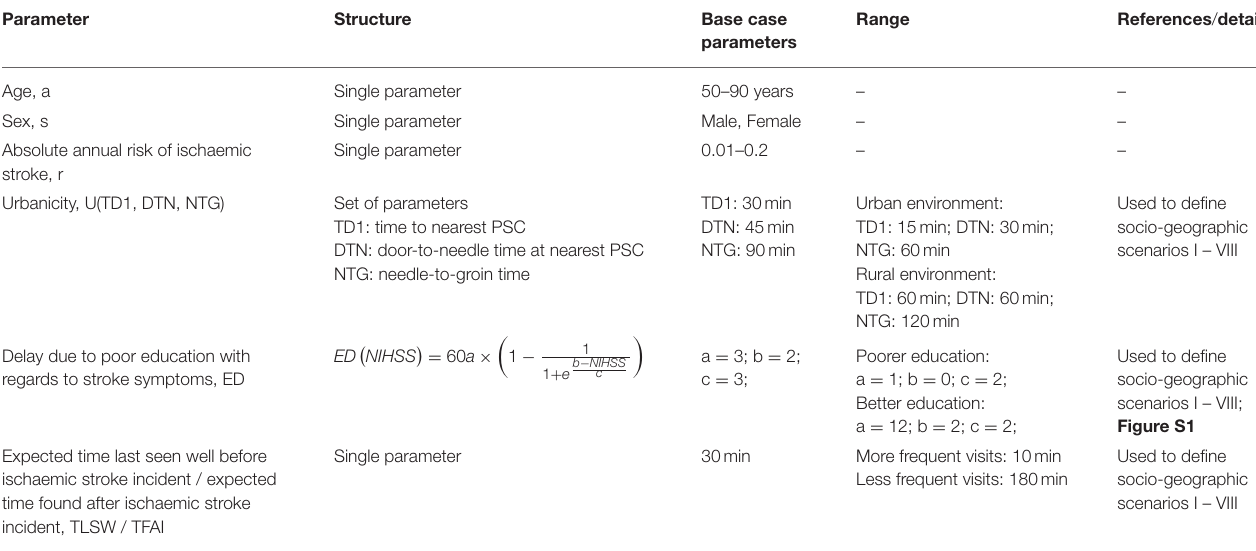
TABLE 1 | Parameters representing individual characteristics and living circumstances used in the